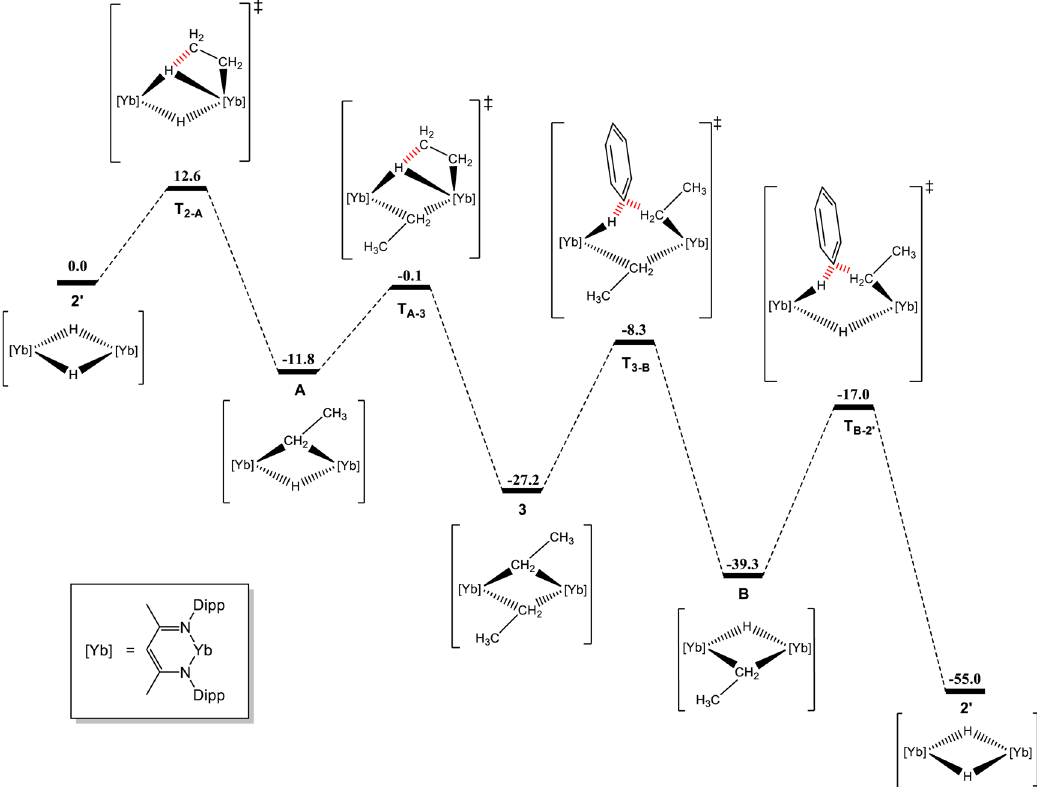
Fig. 5 Density functional theory calculations for the reaction of 2 with ethene and benzene. Computed (DFT, B3PW91) enthalpy pro fi le for the reaction between compound 2 with ethene in benzene at room